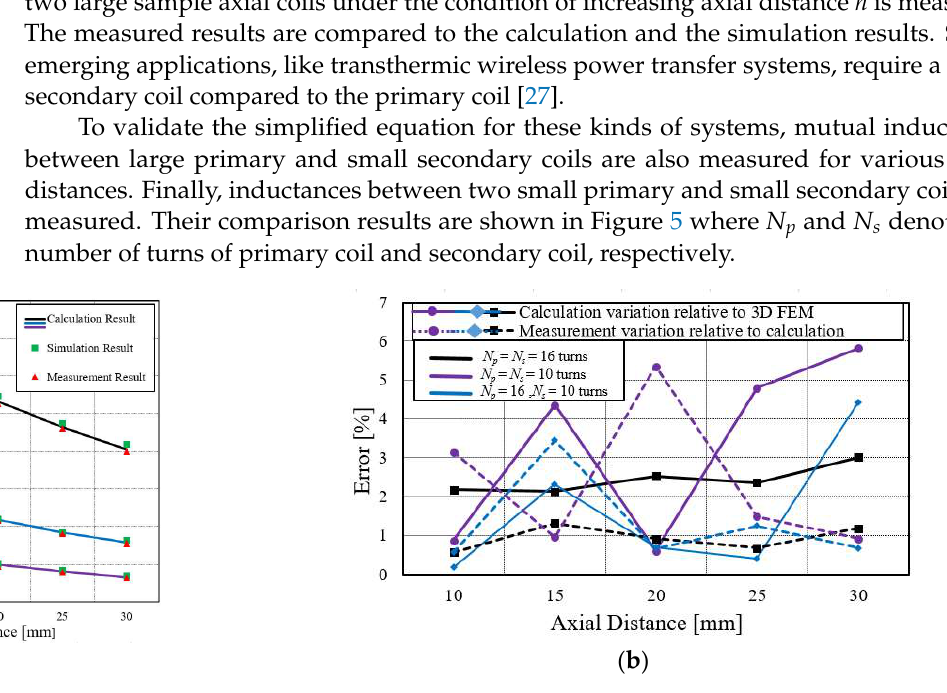
Figure 5. Mutual inductance. ( a ) Comparison between different coils configuration at various axial distances. ( b ) Error comparison of coils relative to calculation and FEM.